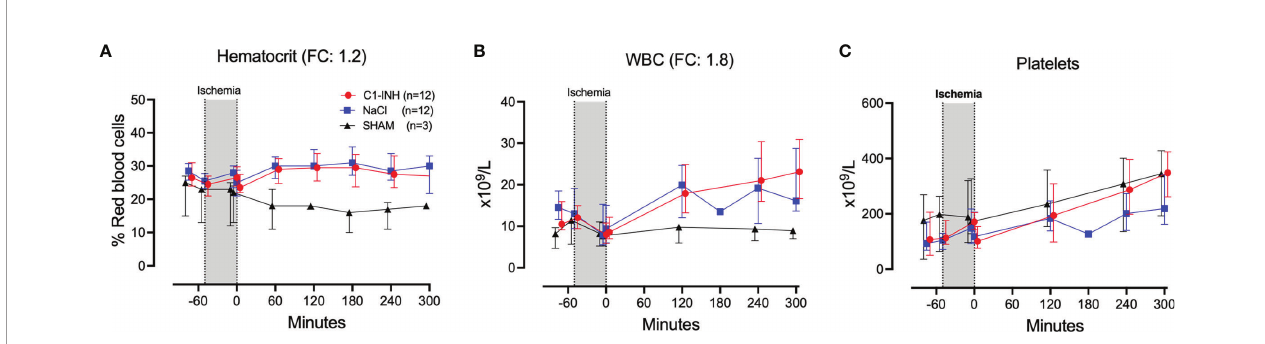
FIGURE 3 | Hematology. (A) Hematocrit, (B) white blood cells (WBC), and (C) platelets were measured in 24 piglets undergoing clamping of the thoracic aorta at the Th8 level. Upfront 12 piglets received human saline intravenously and 12 received C1-INH (250 IU/kg), respectively. Three sham animals received thoracic opening without clamping. Reperfusion started at 0 minutes and lasted 5 hours. Longitudinal time data are expressed as median and interquartile range. “ Ischemia ” indicates the 45 minutes period of clamping. NaCl and C1-INH-groups were combined when there were no differences in the fold change (FC) calculation. FC is the change from before cross-clamp onset to maximum change.